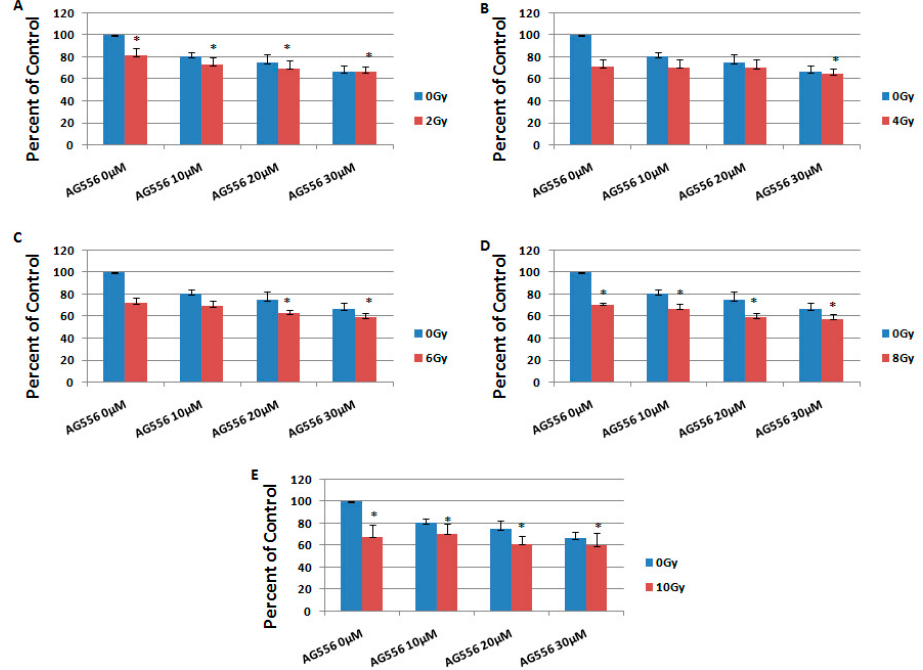
Figure 6. The effect of EGFR inhibition on ionizing radiation response in 15 HGG cells, three days after the treatment. The cells were seeded in 96-well culture plates (3000 cells/well) then irradiated with 2 Gy ( A ); 4 Gy ( B ); 6 Gy ( C ); 8 Gy ( D ); 10 Gy ( E ) and treated with 10 μ M, 20 μ M or 30 μ